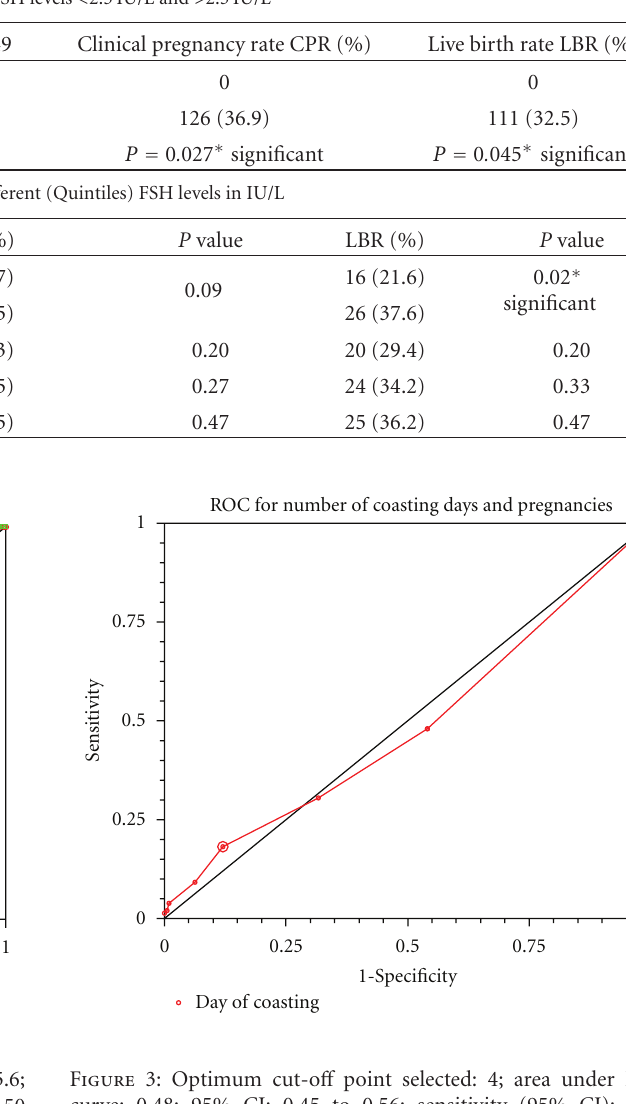
Table 2: FSH levels (IU/L) and outcomes on the hCG administration day.